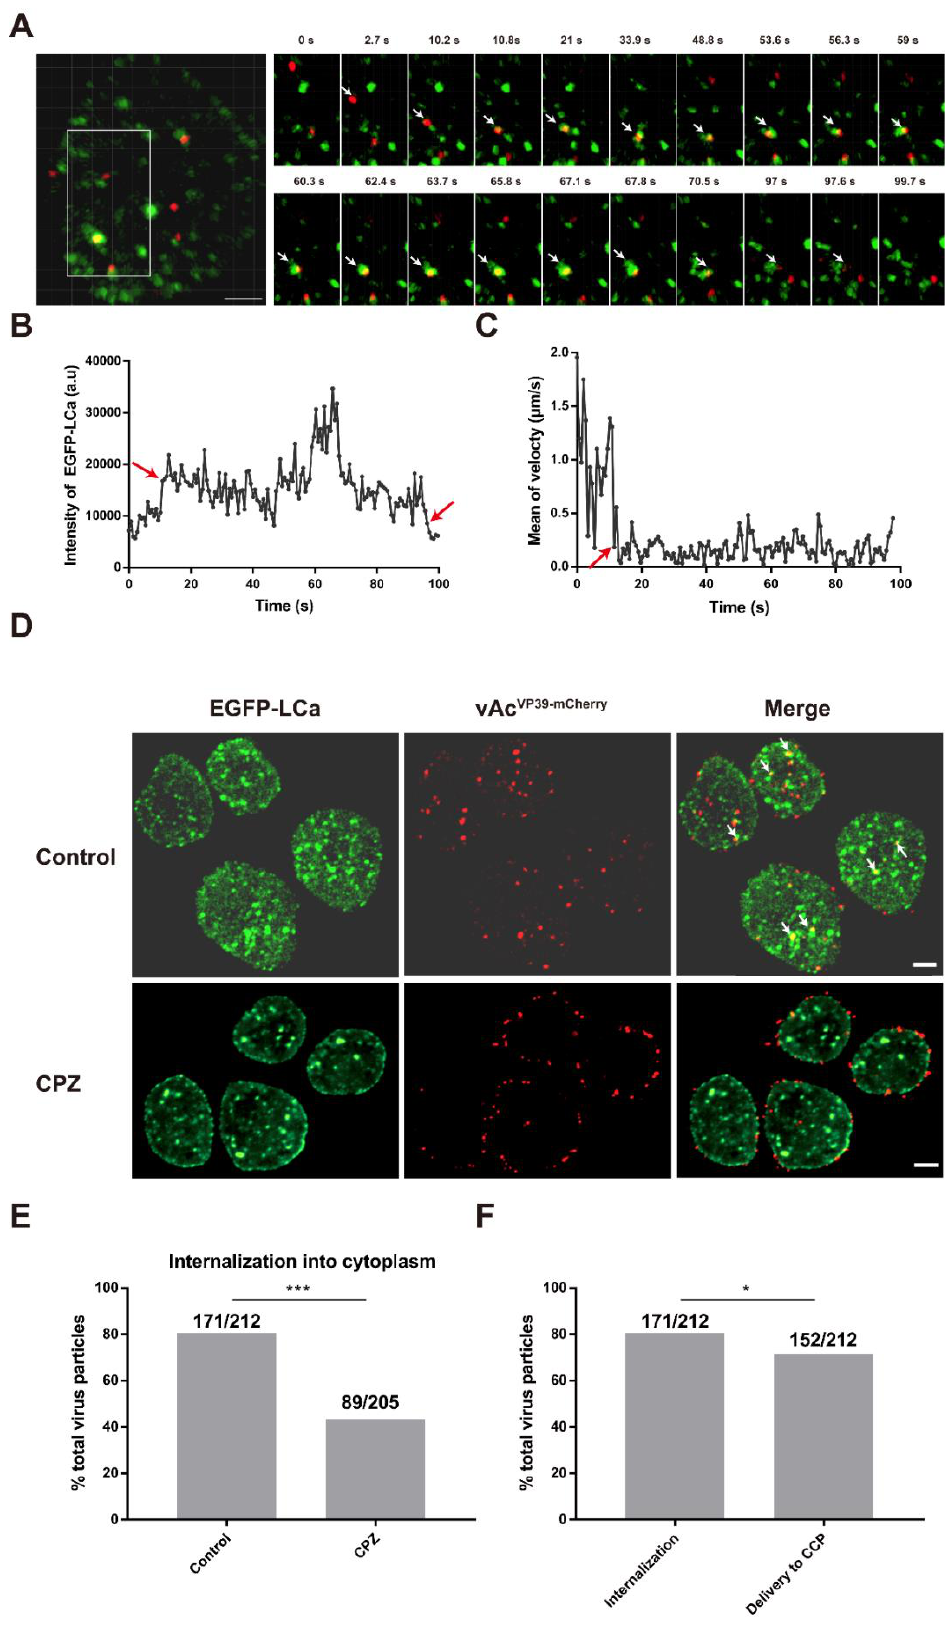
Figure 2. AcMNPV enters cells via clathrin-mediated endocytosis and a clathrin-independent pathway. ( A ) A representative example of a virus particle (vAc VP39-mCherry , red) delivered to a clathrin-coated pit (CCP) (Sf EGFP-LCa , green). When the intensity of EGFP-LCa decreased for more than five consecutive timepoints, the tracking of the virus particles will be terminated. Left panel: Fluorescent